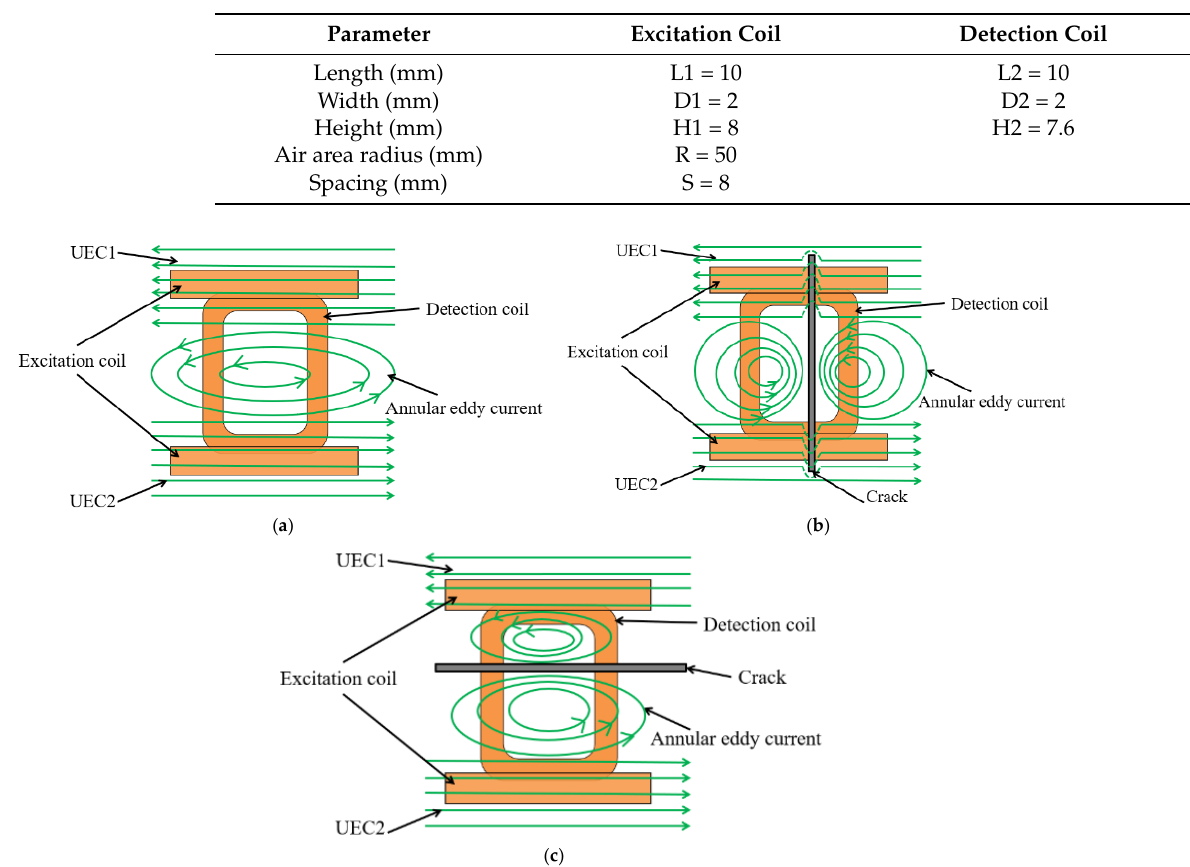
Figure 2. The structure diagram of the dual-excitation UEC probe. Table 1. The structural parameters of the simulation model.